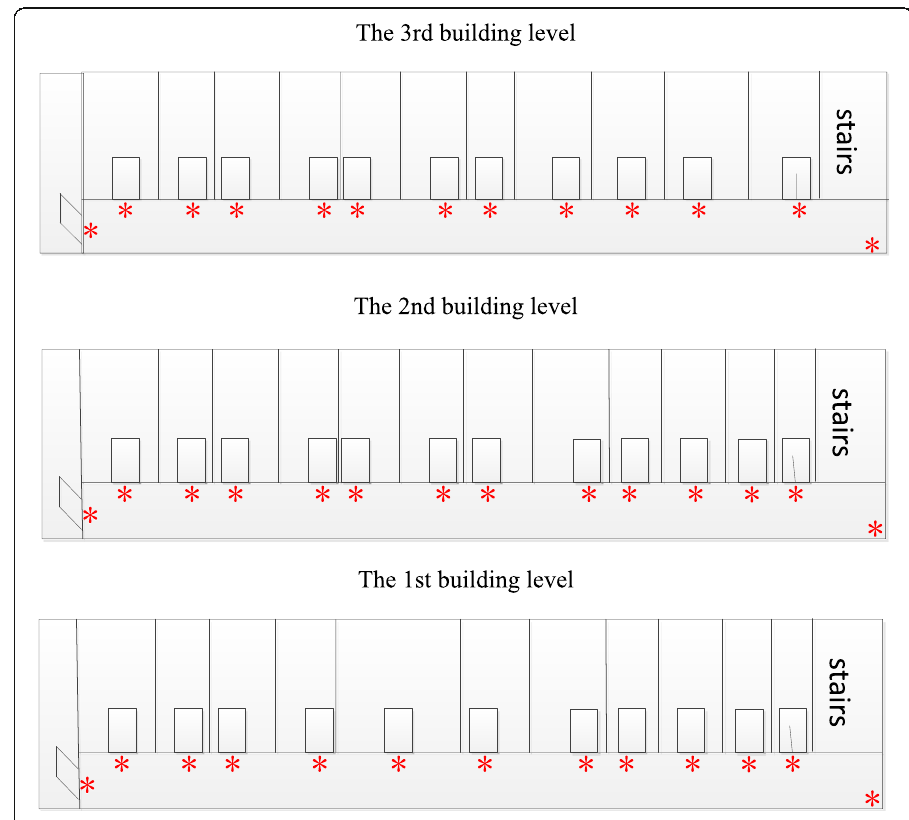
Fig. 4 Location points of school